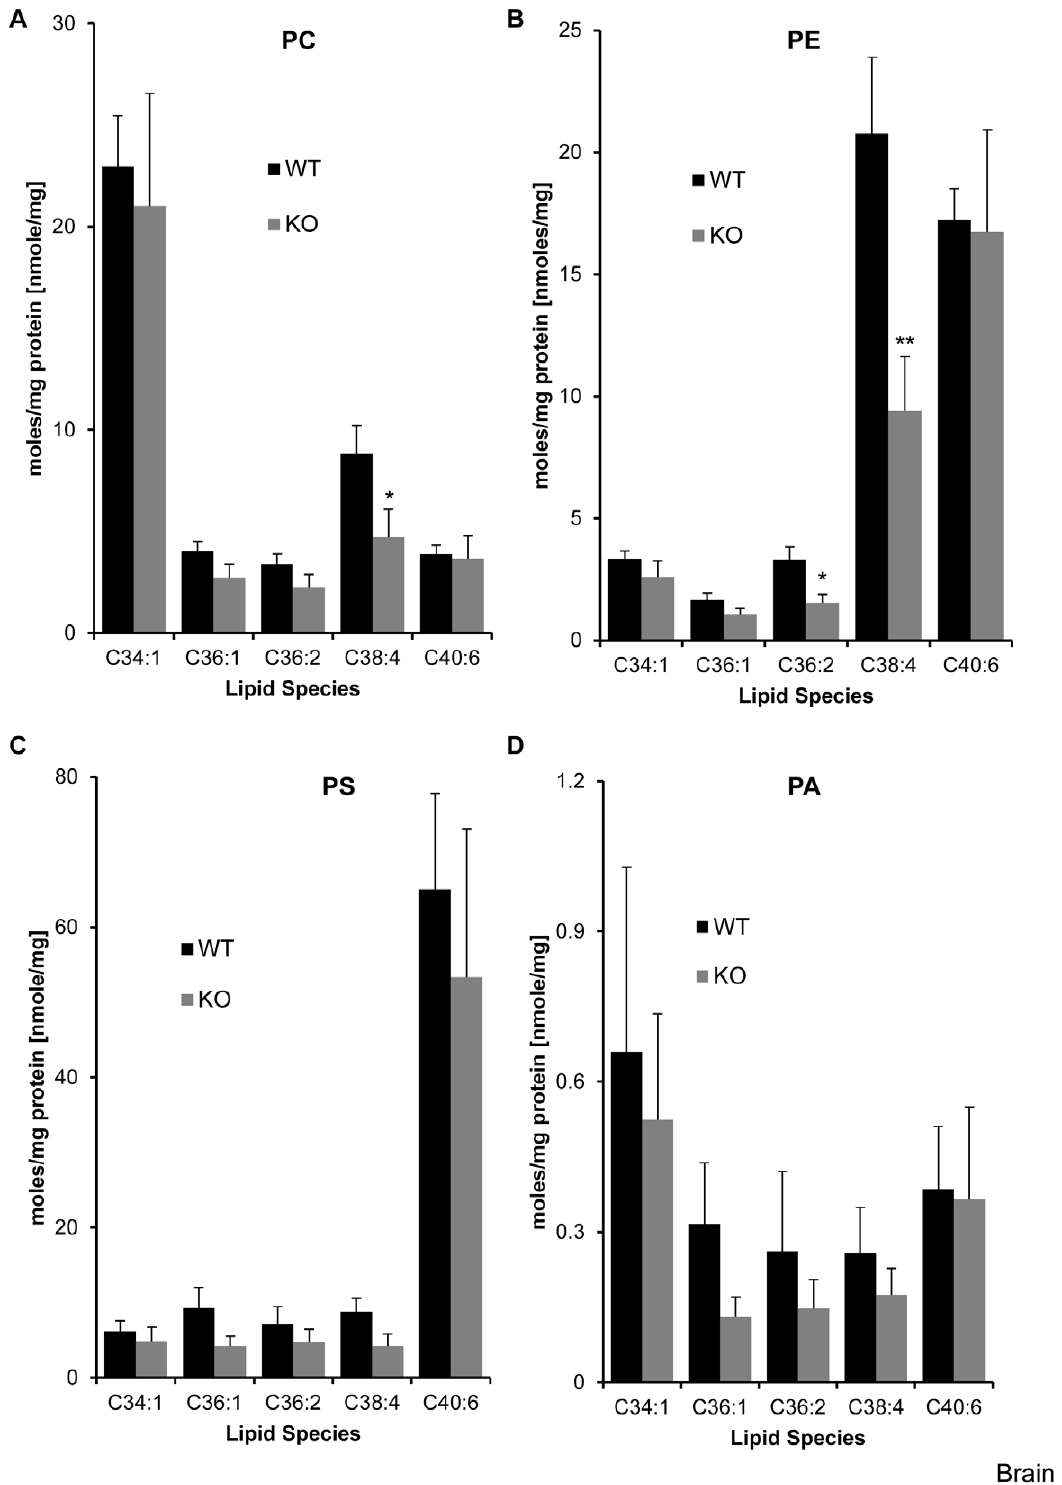
Figure 5. Effect of LPIAT1 knockout on brain phospholipid molecular species. Brains from 13 day old littermates expressing (LPIAT1 + / + (WT)) or lacking (LPIAT1 2 / 2 (KO)) LPIAT1 were homogenized and lipids extracted from 0.5 mg wet weight as described in Materials and Methods. Targeted molecular species of PC ( A ), PE ( B ), PS ( C ) and PA ( D ) were detected by MRM mass spectrometric analysis as described in Materials and Methods. Data are expressed as moles/mg protein, normalized to relevant internal standards. Shown are mean 6 SD, n=4 for both WT and KO. Data were analyzed by T-test. *p # 0.05, **p # 0.005.